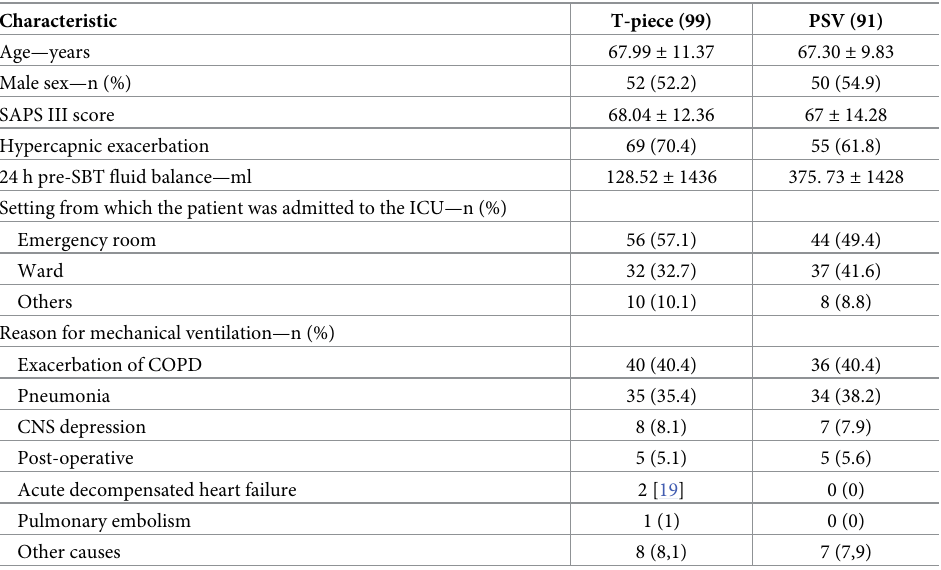
Table 1. Baseline characteristics of the study population.